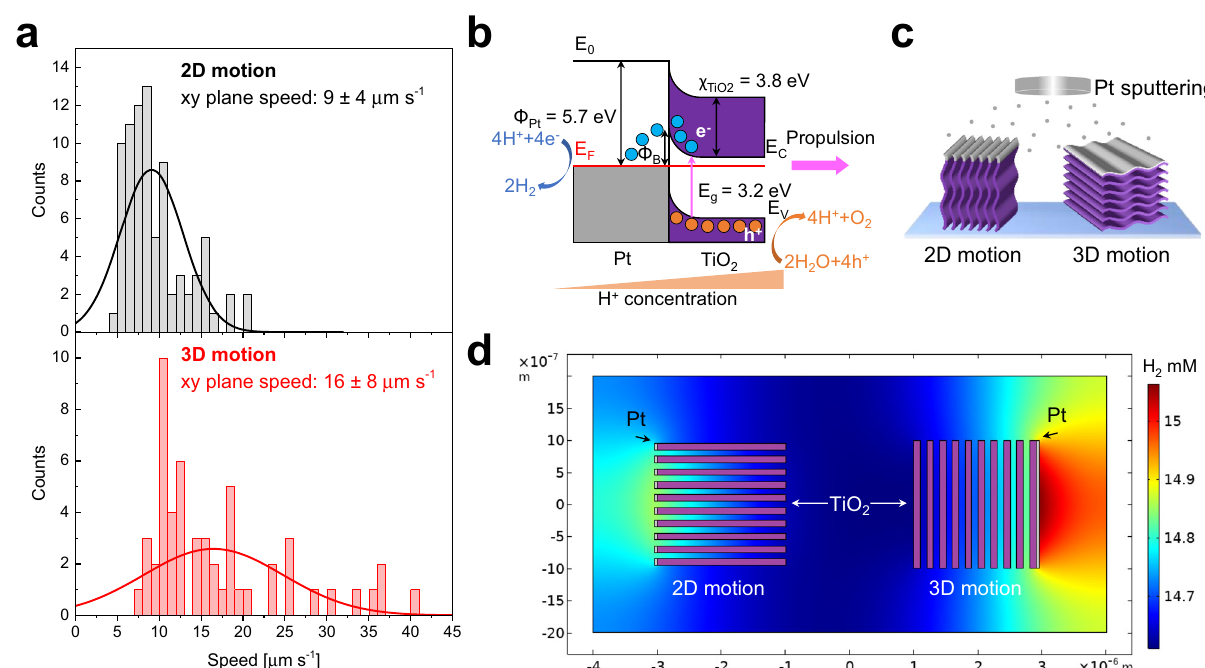
Fig. 4 Analysis of the MXene-derived γ -Fe 2 O 3 /Pt/TiO 2 microrobots' 2D and 3D motion. a Speed distributions of the MXene-derived γ -Fe 2 O 3 /Pt/ TiO 2 microrobots (thermal annealing condition: 0 min at 550 °C) showing 2D and 3D motion in water at pH 7 under UV-light irradiation. b Scheme of the general motion mechanism of Pt/TiO 2 microrobots (E 0 is the vacuum level, E F is the Fermi level, Φ Pt is Pt work function, Φ B is the Schottky barrier height, E C , E V , E g , and χ TiO2 are TiO 2 conduction and valence band levels, optical bandgap, and electron af fi nity). c Scheme of the two MXene-derived γ -Fe 2 O 3 /Pt/ TiO 2 microrobots' con fi gurations originated from the MXene-derived TiO 2 microparticles ’ multi-layered structure and orientation with respect to the Pt target during Pt deposition. d Numerical simulation of the H 2 concentration spatial distribution produced in 0.1 s for the cross-section of the two con fi